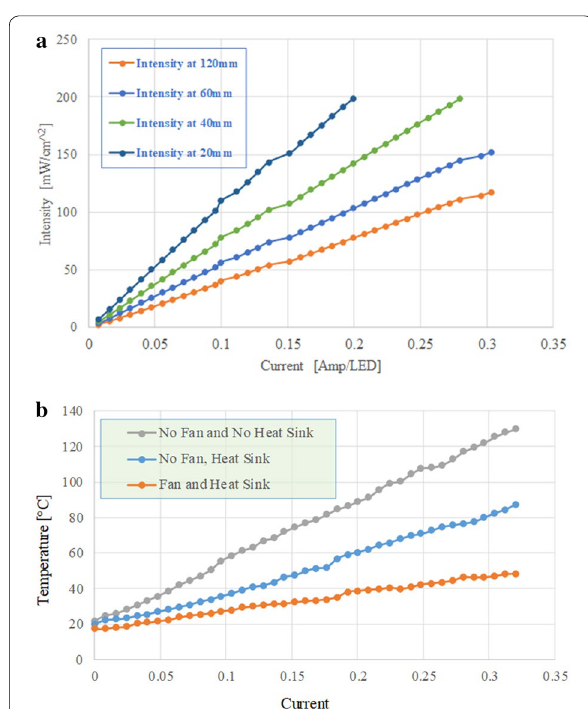
Fig. 7 UV-LED light source characteristics: a light intensity via applied current per led at a different distance, and b temperature variation over the applied current with different cooling